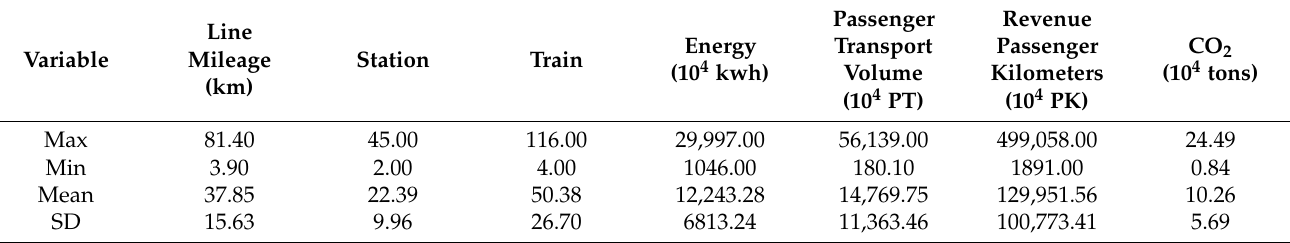
Table 1. Descriptive Statistics 1